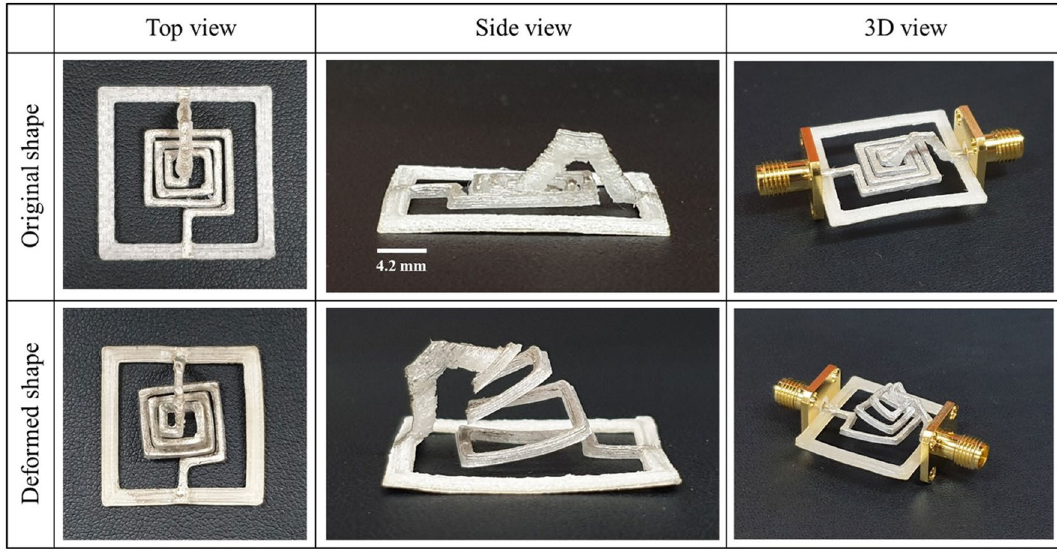
Figure 2. Images of the fabricated inductor from various